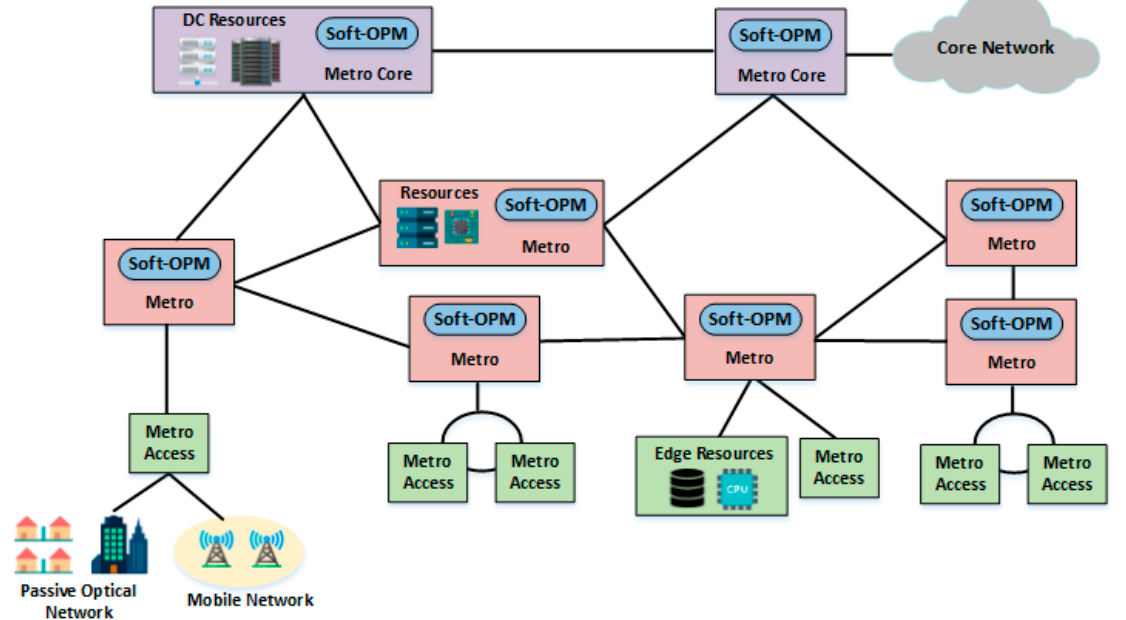
Figure 4. ARMONIA multilayer elastic optical metropolitan network architecture.